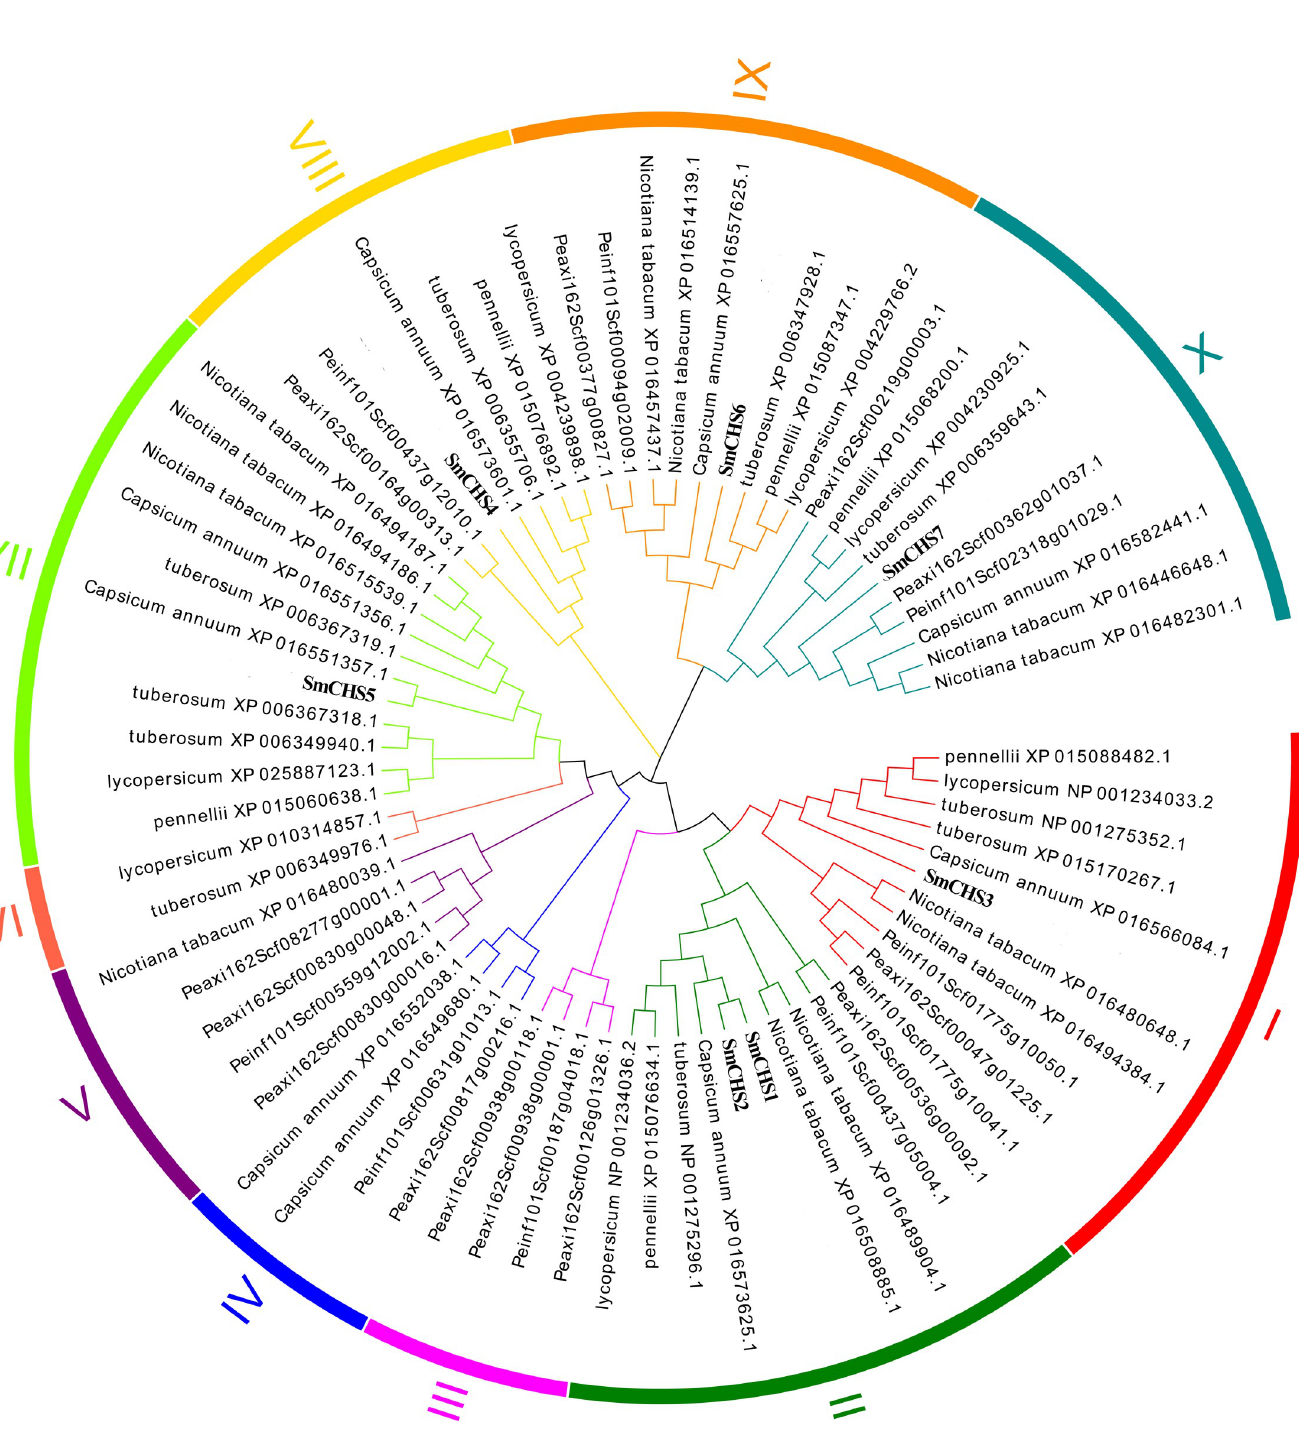
Fig 4. Phylogenetic tree of CHS genes in Solanaceae species. The colored region is associated with 10 groups of proteins (Group Ⅰ to Ⅹ ).